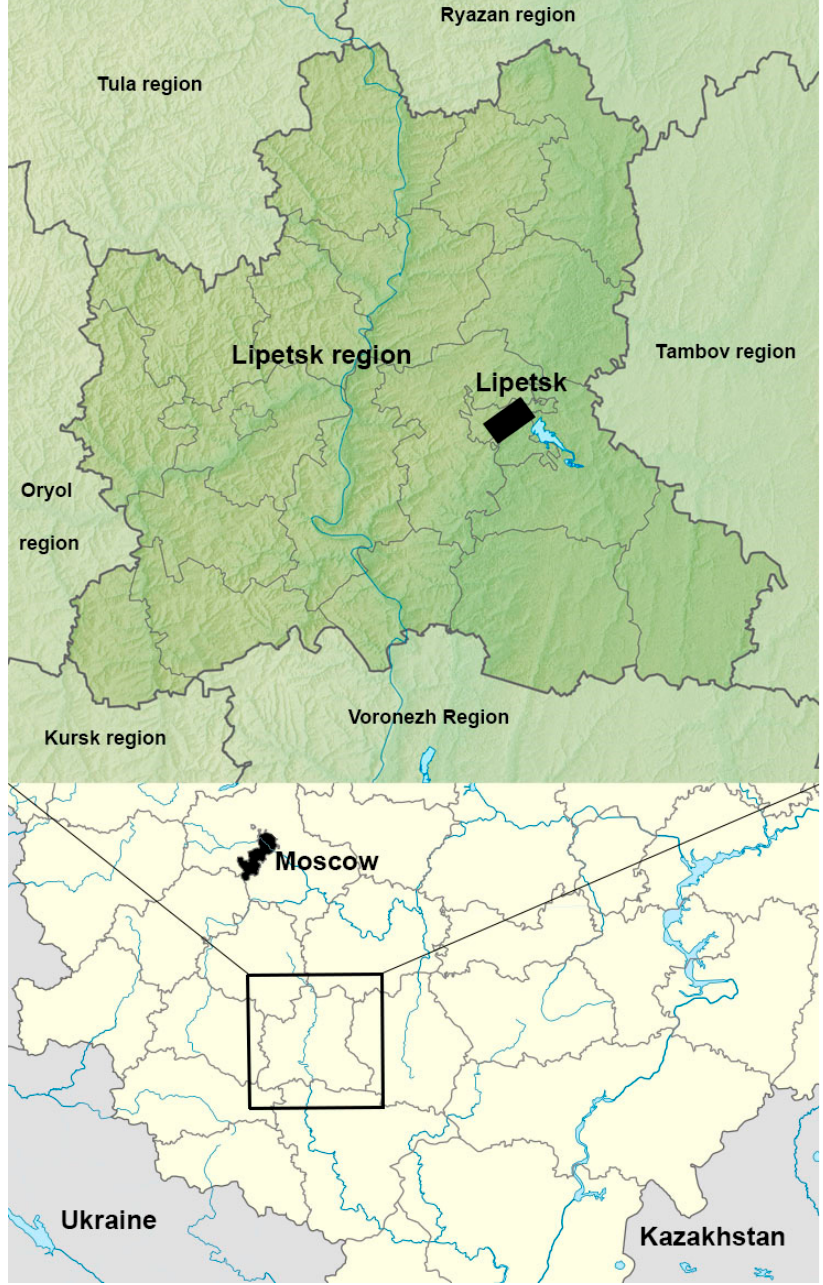
Figure 1. Map of the Lipetsk region.